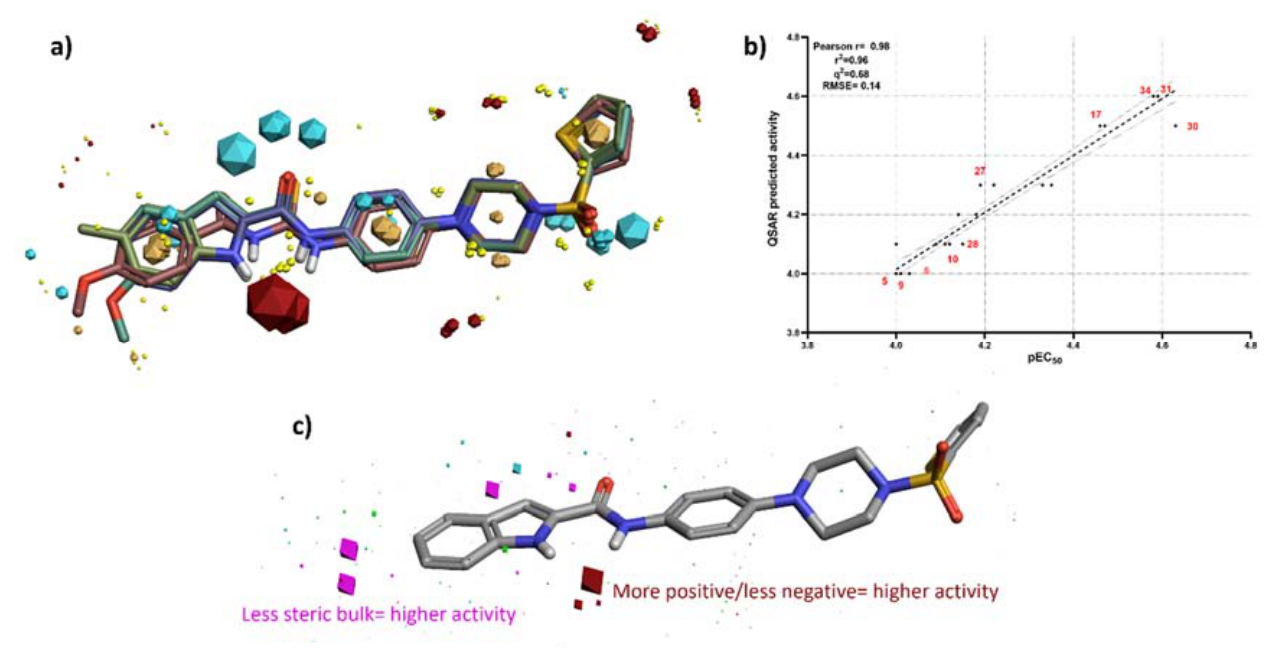
Figure 3. 3D-QSAR results for murine norovirus. ( a ) Pharmacophore template with the respective molecular field points generated using compounds 8, 30, 32 and 34; ( b ) Plot of experimental (expressed as pEC 50 ) vs. predicted activity of the 3D-QSAR model; ( c ) The visual representation of the coefficients and variance field points modulating the bioactivity in the derived 3D-QSAR model.